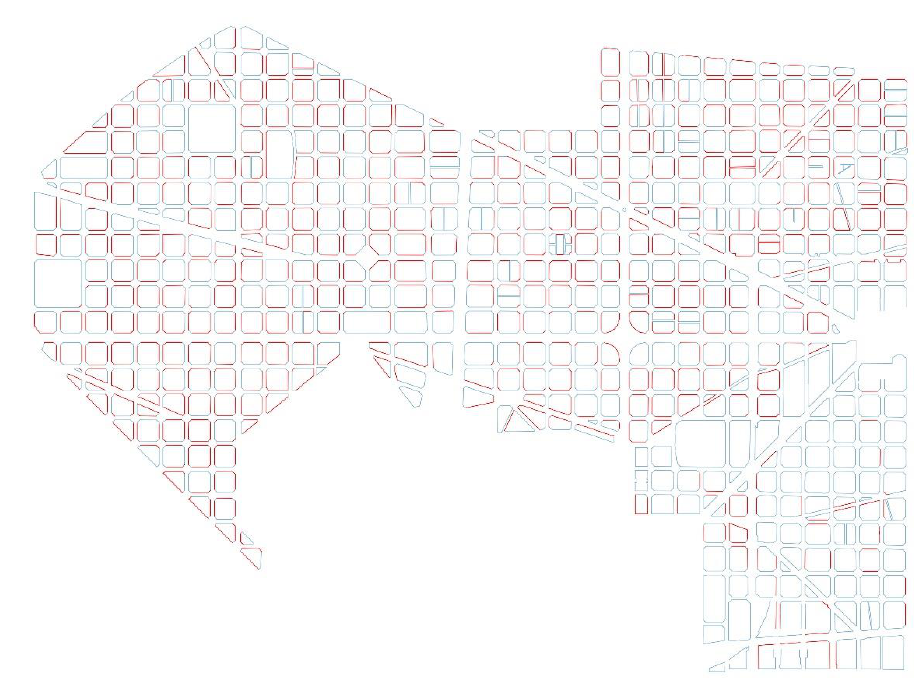
Figure 11. Streets with essential services in the Eixample ( red ) versus streets with other type of activities or without activities ( blue ).